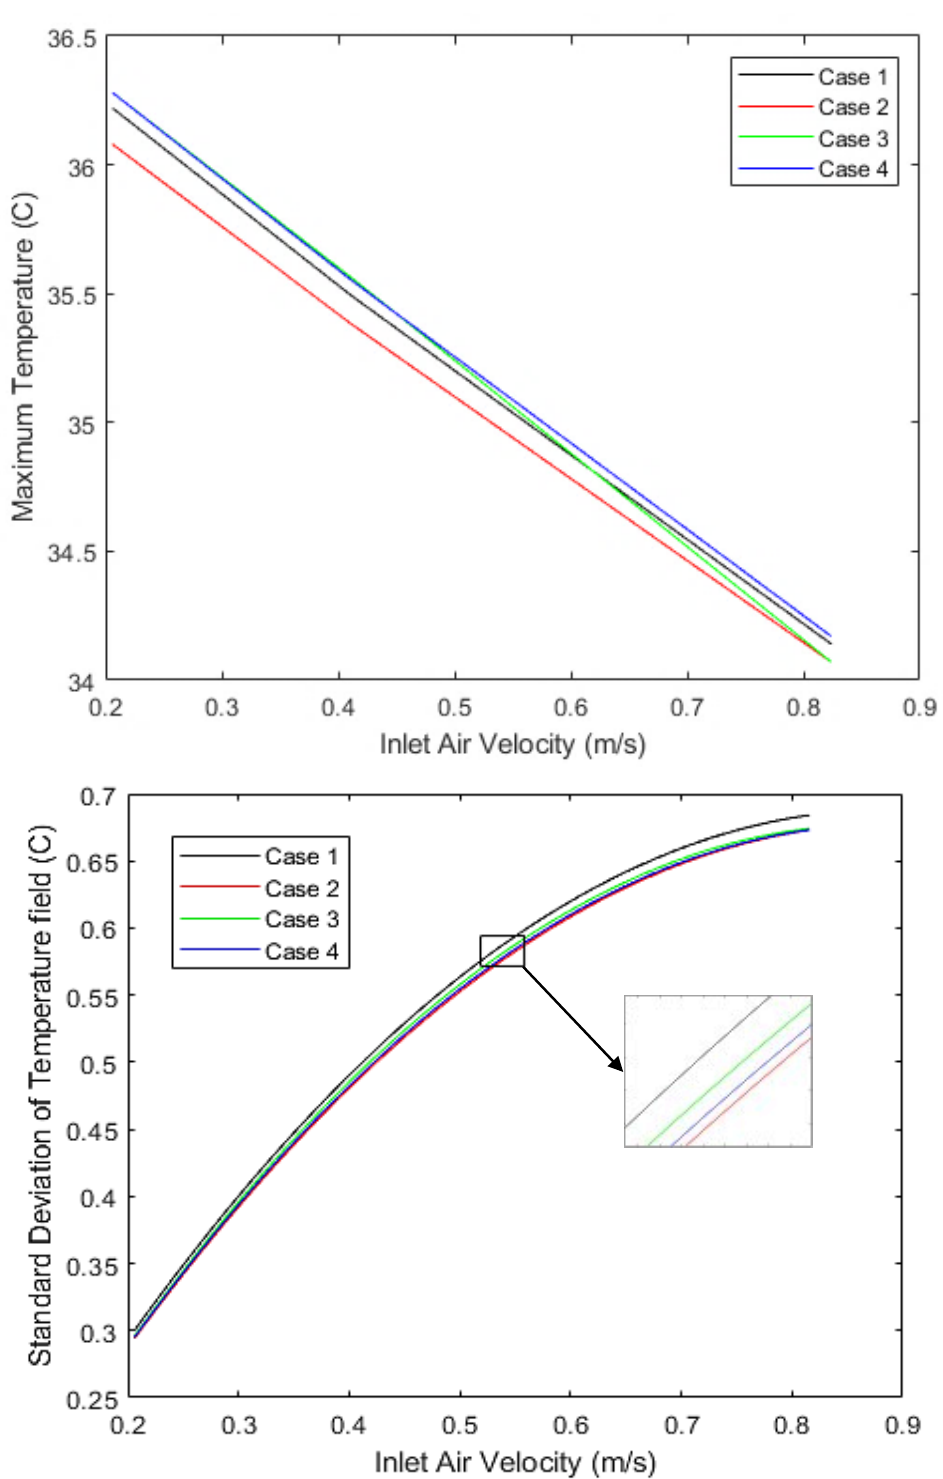
Figure 9. Battery maximum temperature and standard deviation of temperature profile against inlet air velocity for different cases at 27ºC and t =